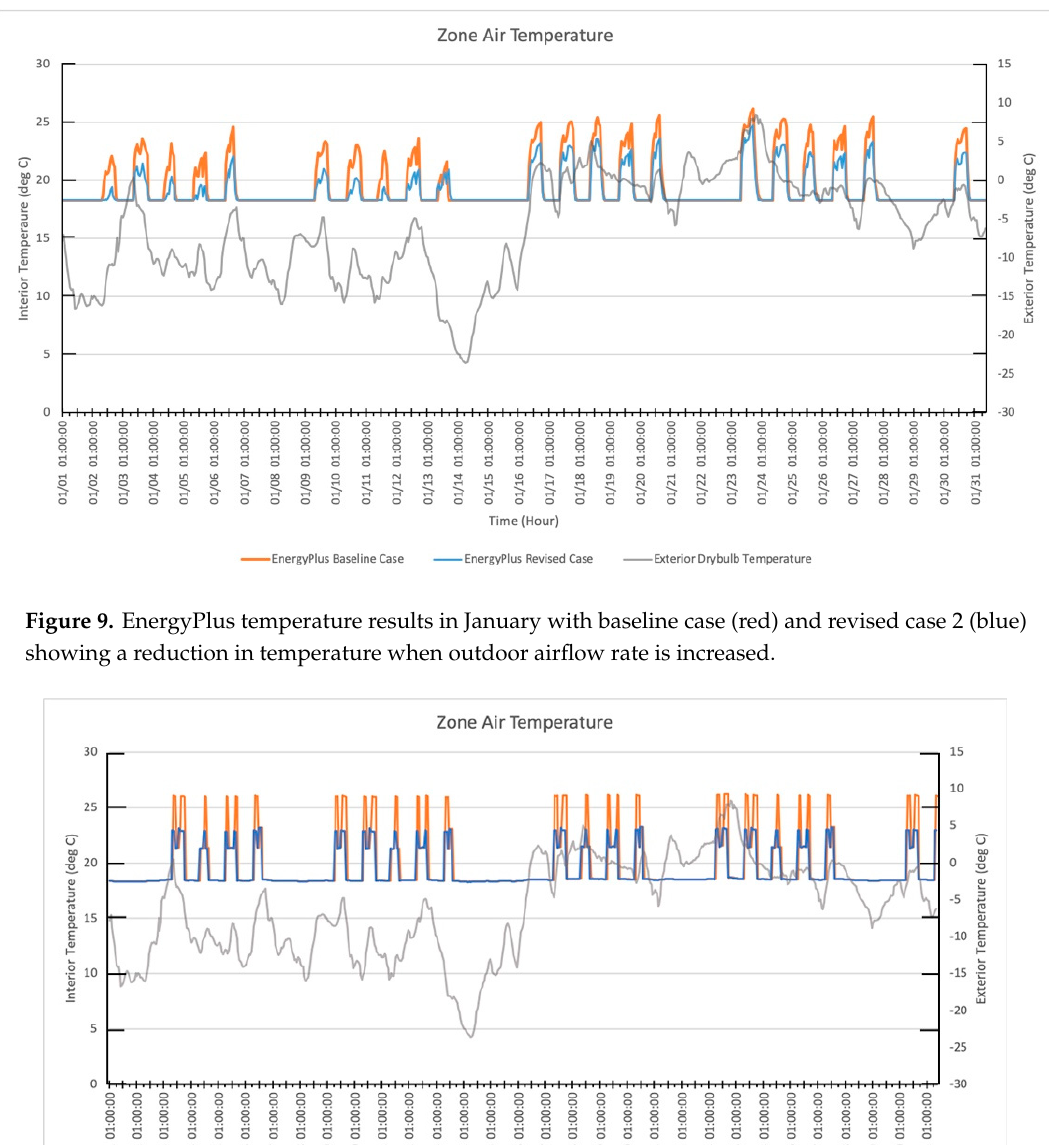
Figure 11. EnergyPlus temperature results of a day, showing a reduction in indoor air temperature. Figure 12. eQUEST temperature results of a day, showing a reduction in indoor air temperature.